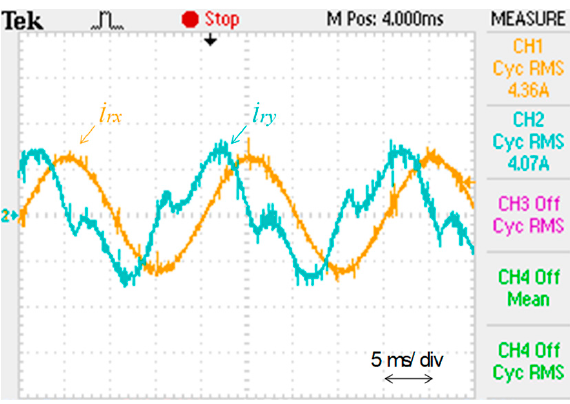
Figure 29. Experimental results (when one load section is loaded): phase x compensation current ( i 5 A/div); phase y compensation current ( i ry : 5